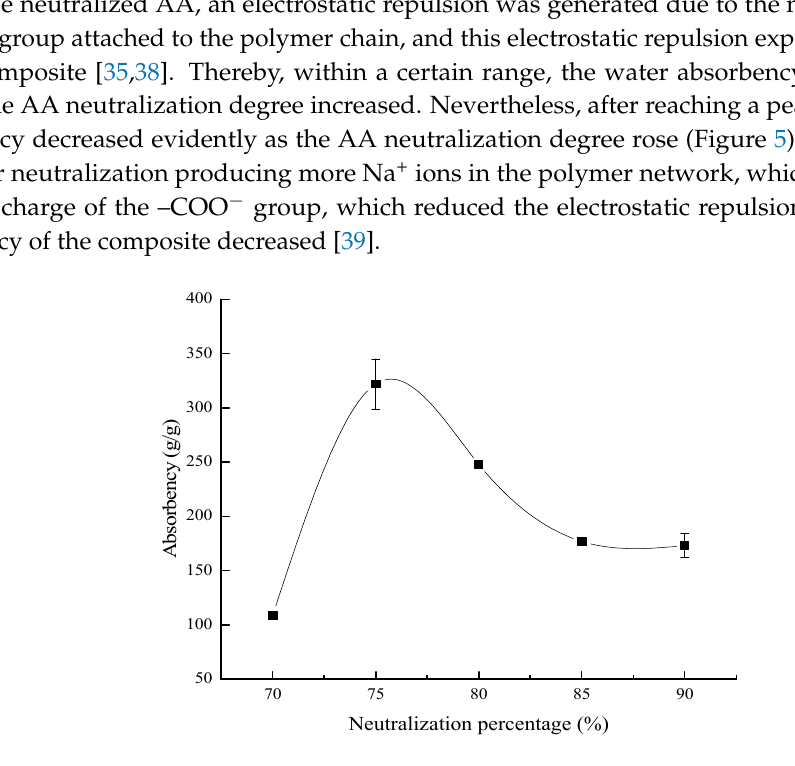
Figure 5. The influence of the AA neutralization degree on the water absorbency.